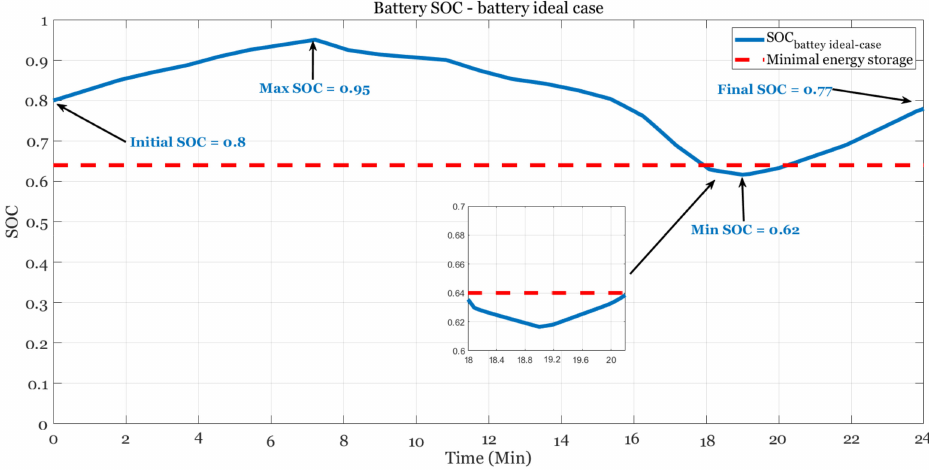
Figure 16. Battery SoC during the load cycle based on standard sizing